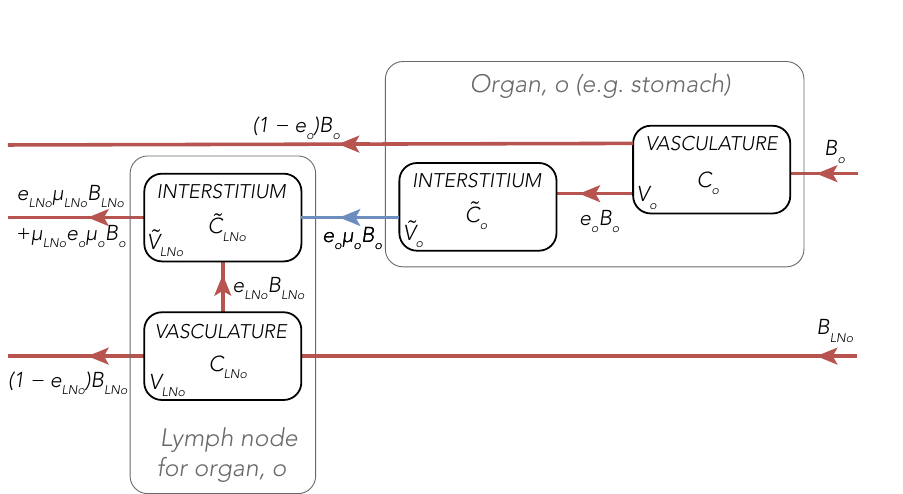
Figure 3. Organ, o , and draining lymph nodes for organ, o , are represented in the model as separate vascular and interstitial compartments. T cells flow from the cardiac output compartment (previously defined as left atrium, left ventricle, aorta and large arteries) to each organ, o , with a blood flow B o , from which a proportion, e o B o , enters the interstitial space per unit time. A proportion of T cells, e o µ o B o , flows via lymphatics from the interstitial sub-compartment of organ, o , into the draining lymph nodes per unit time. T cells also enter organ, o , -draining lymph nodes through the lymph node blood supply, denoted B LN vasculature compartment, a proportion of T cells extravasates into the lymph node interstitial compartment B LN (at a rate e LN ). T cells drained to organ, o , -draining lymph nodes are returned to the systemic circulation o o (at a rate e LN ) B LN and ( 1 − e LN , respectively). Different suffixes, such as LA&LV (combined left atrium, left ventricle, and o o large arteries), RA&RV (combined right atrium, right ventricle, and large veins), PC (pulmonary circuit), med (mediastinal lymph nodes) are also